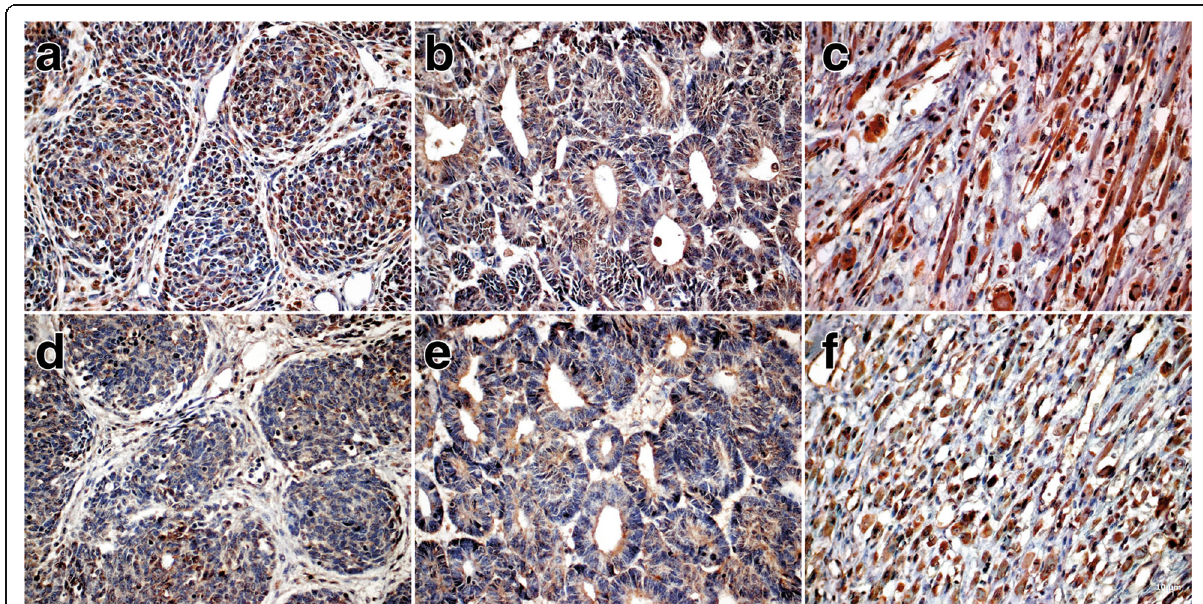
Fig. 1 Immunohistochemical expression of RARA and CRABP2 in nephroblastoma samples. RA immunoexpression: a , blastema; b , epithelium; c , stroma; CRABP2 immunoexpression: d , blastema; e , epithelium; f , stroma (40×)